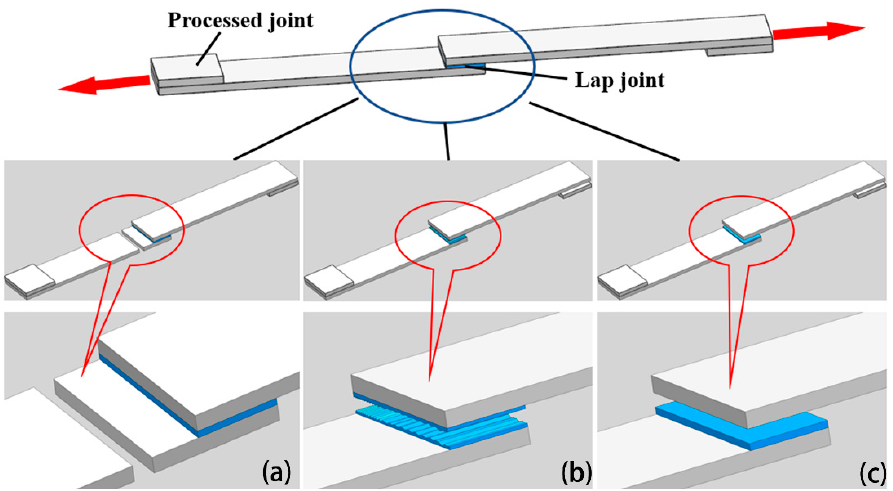
Figure 9. Typical failure modes of lap joints: ( a ) Coupon failure; ( b ) Intralaminar failure; ( c ) Interface failure.